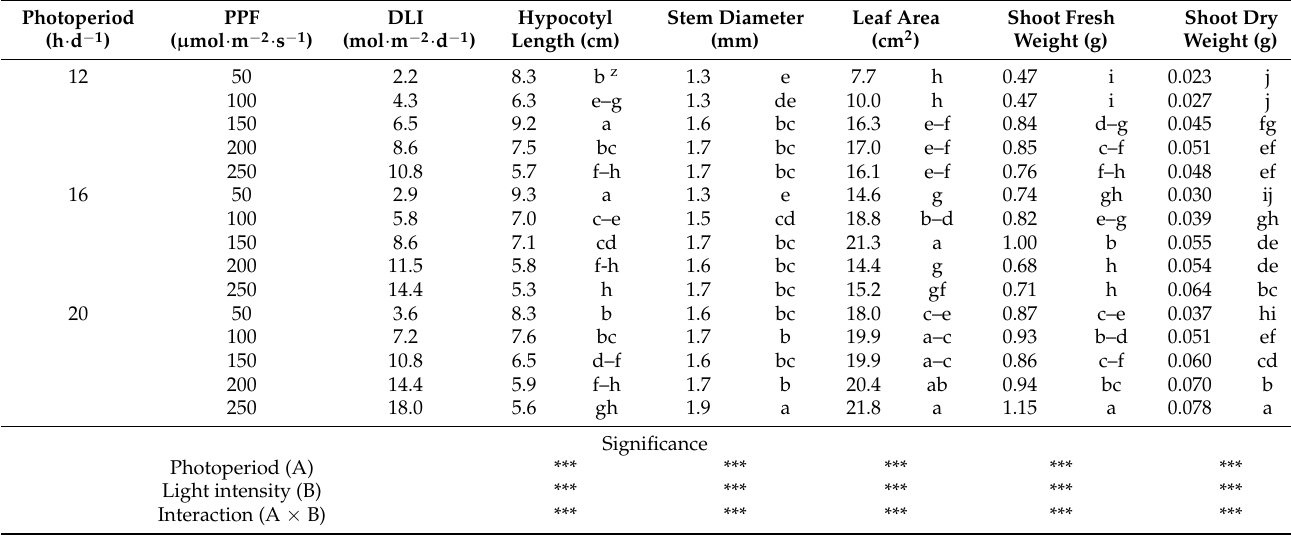
Table 3. Growth of cucumber scions as affected by the different photoperiod and light intensity at 6 days after cultivation in a PFAL.